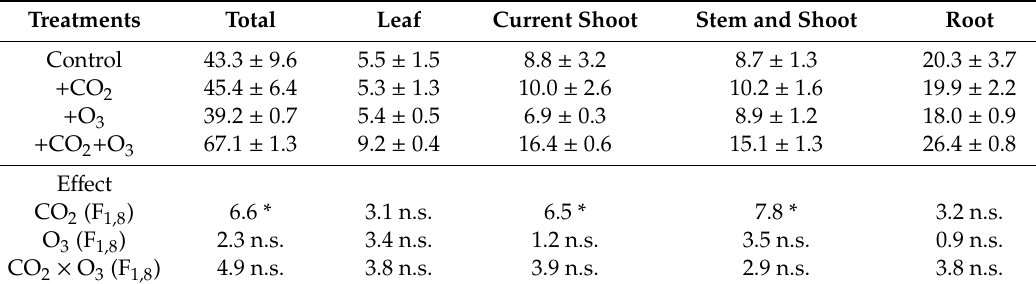
Table 2. Dry mass of plant tissues (whole plant; Total, leaf weight; Leaf, current shoot weight; Current shoot; stem and shoot weight; Stem and shoot, root weight; Root) of the seedling of F. crenata grown under ambient air (control), elevated CO 2 ( + CO 2 ), elevated O 3 ( + O 3 ), and the combination of elevated CO 2 and O 3 ( + CO 2 + O 3 ). Values at upper half lines are means ± SE of three replicates for each treatment. F values of analysis of variance (ANOVA) to test the main e ff ects of CO 2 , O 3 , and their interactions are also shown at lower half lines. Significant e ff ects are indicated by *; p < 0.05, and n.s.; non-significant. Treatments Total Leaf Current Shoot Stem and Shoot Root Control